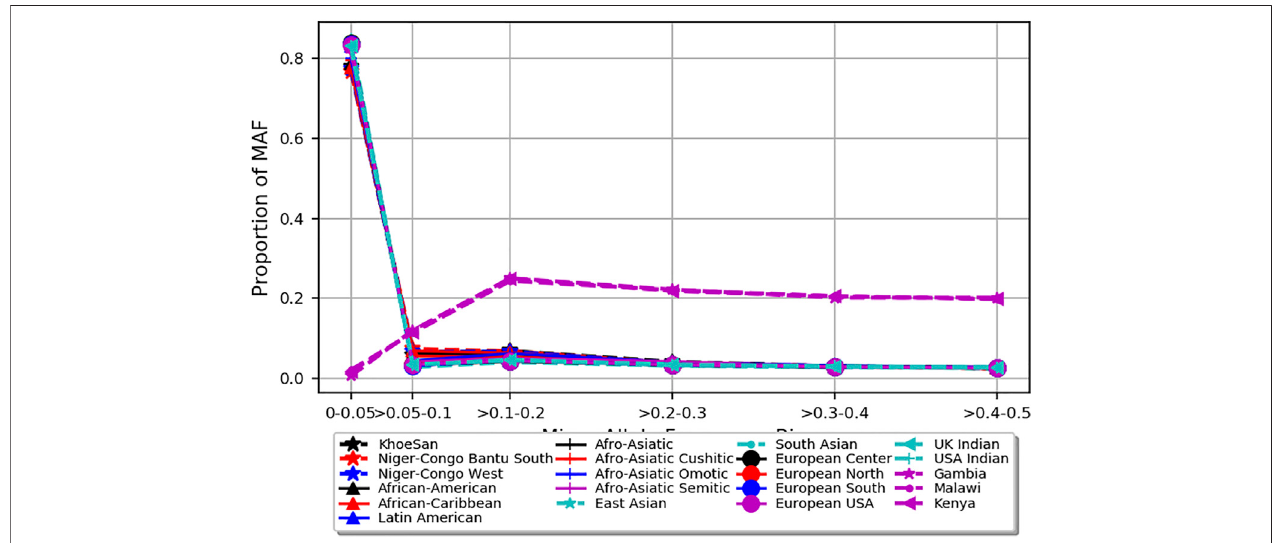
FIGURE 6 | Depicts minor allele frequency (MAF) bins of SNPs mapped to severe malaria resistance candidate genes in three malaria endemic populations (Gambia, Malawi, and Kenya) and global populations composed of 20 ethnic groups. Y -axis represents allele frequency, and X -axis represents different MAF bins. Populations were represented by different colors and